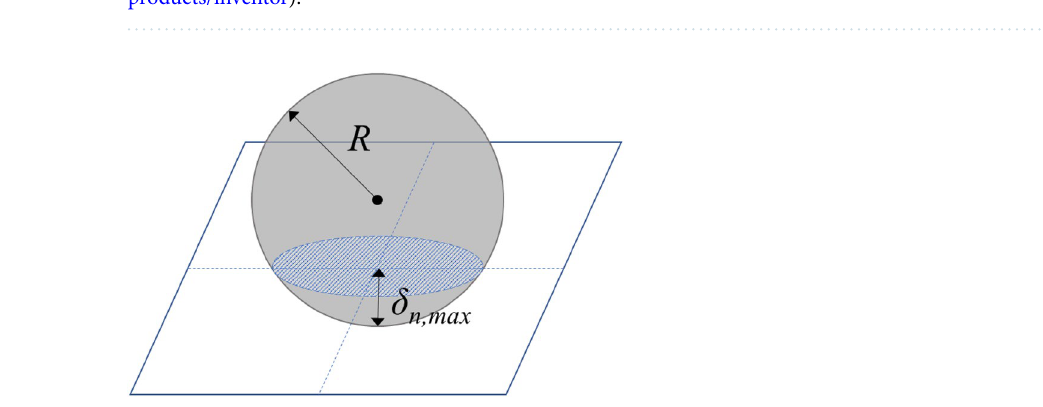
Figure 3. Superimposed shot marks for calculating total coverage (Inventor 2021, https:// www. autod esk. com/ produ cts/ inven tor).